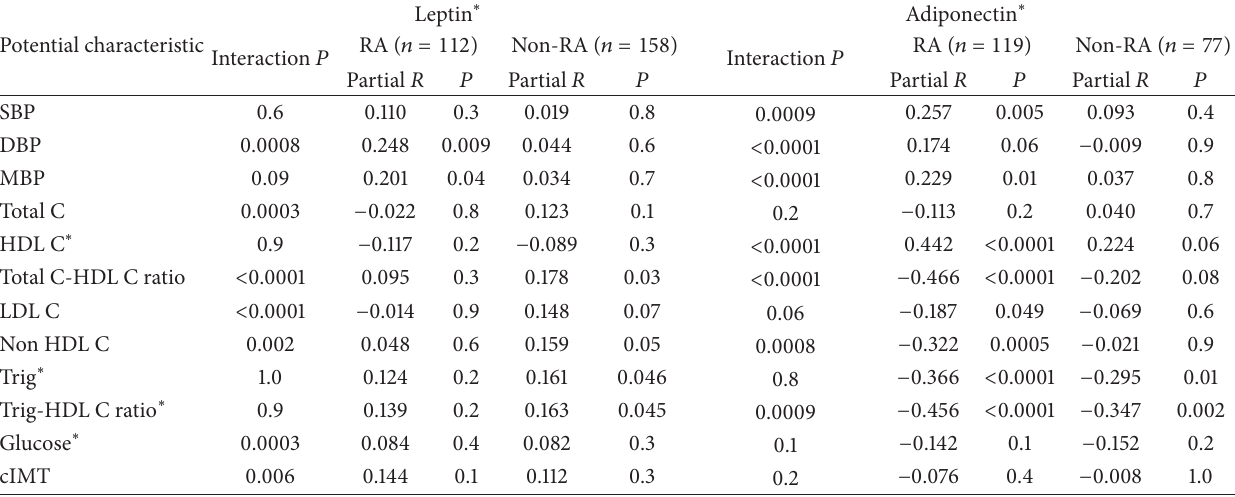
Table 3: Impact of RA on the age and sex adjusted relationships between serum adipokine concentrations and metabolic risk factors and carotid atherosclerosis.